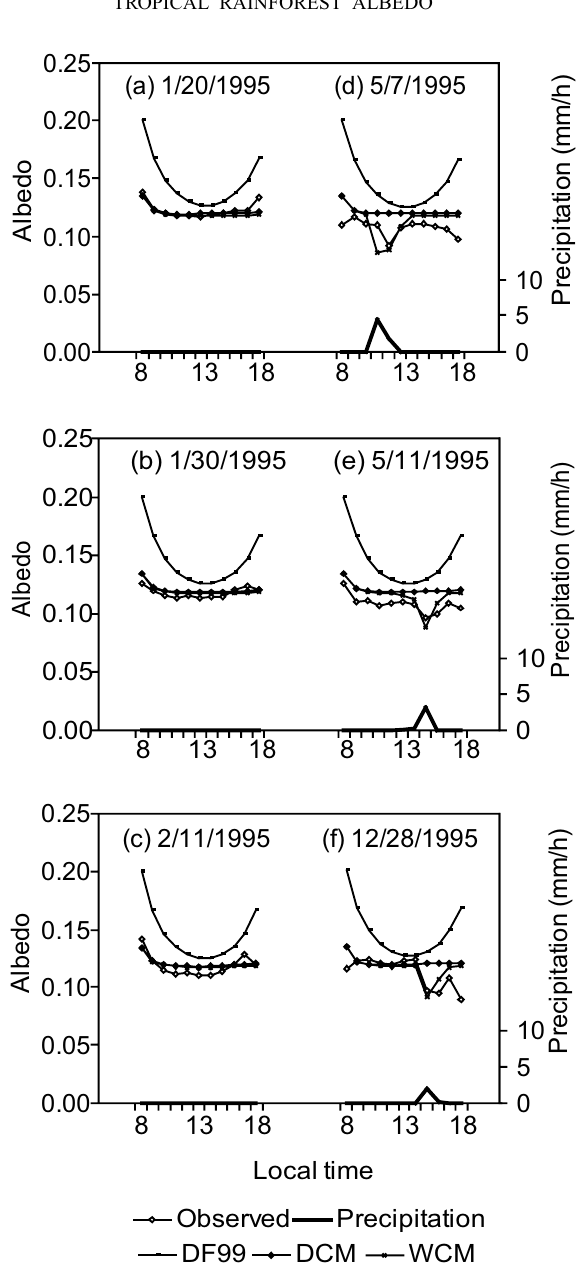
Fig. 3 – Diurnal variation of the simulated and observed surface albedo in the Ducke Reserve for the selected